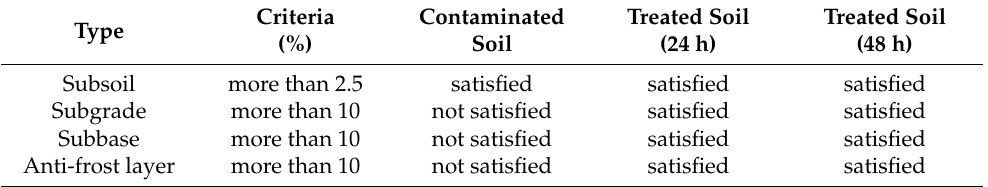
Figure 12. Modified CBR test results. Table 5. Comparison of tested soils’ modified CBR with criteria for road construction fill materials.